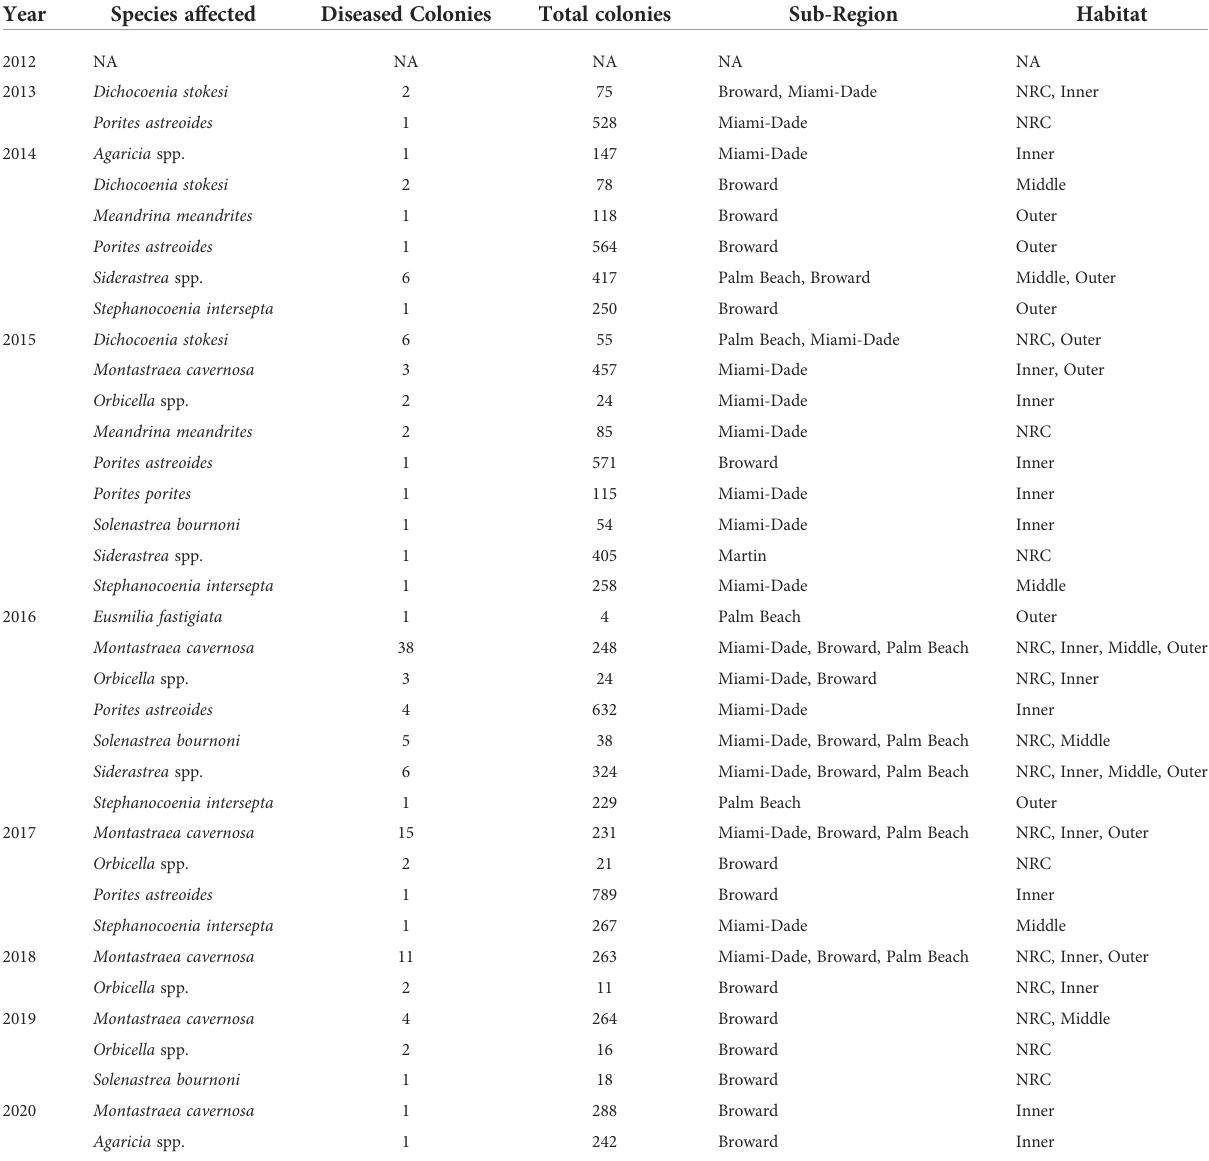
TABLE 2 Annual abundance of stony coral species (colonies ≥ 4 cm maximum diameter) observed with disease lesions consistent with SCTLD*.